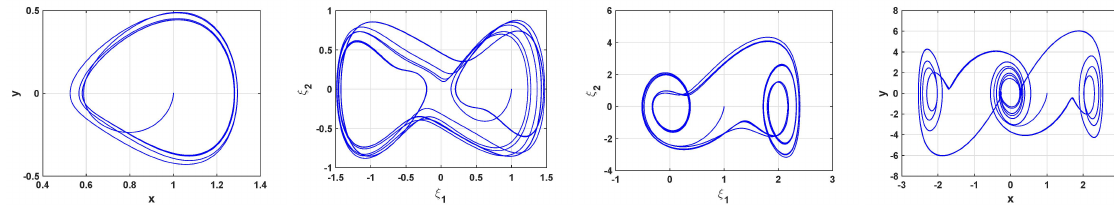
Fig. 5 Chaos diagrams in case of c = 0 . 5, ω = 1, e = 0 at Γ =0.522,1,25 and 50 from to left to right.